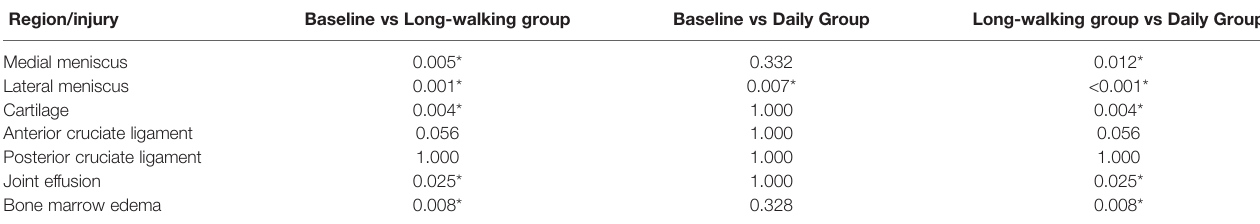
TABLE 3 | Multiple comparisons of injuries in different areas of the knee joint (n =